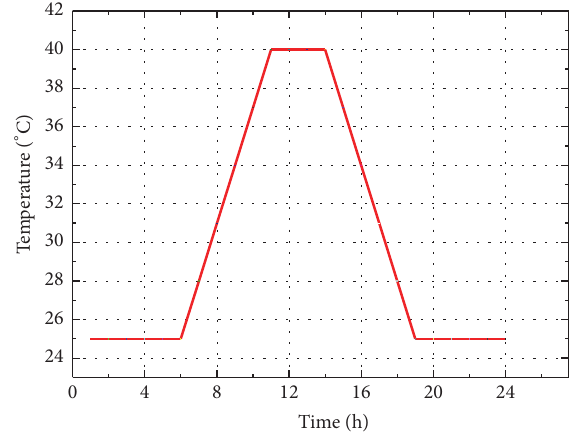
Figure 5: Temperature cycle of marine